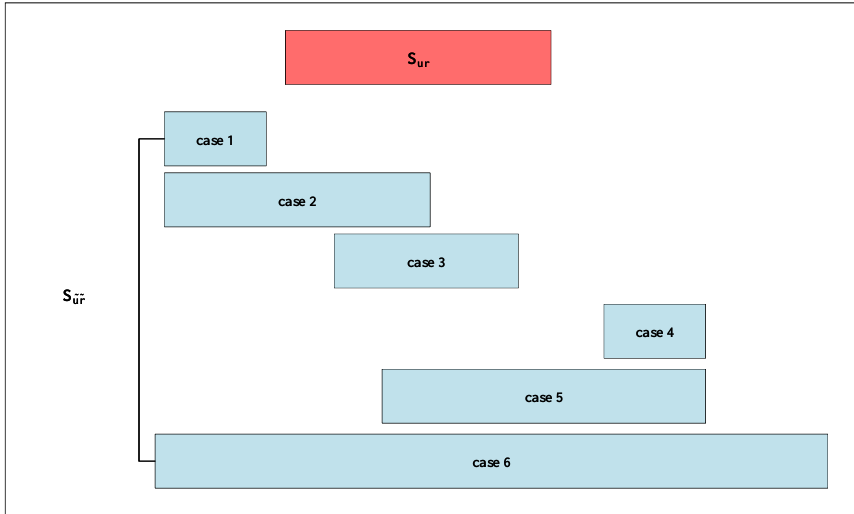
Figure 6. The relative position of the interval cut by the algorithm and the manual annotation interval. For cases 1–3, it can be seen that the ending point of the segmentations using the TS algorithm is smaller than those manually labeled. If the ending point of the blue parts is smaller than the starting point of the red part, there is no overlapping area. Therefore, max ( 0, ( ˜ r j − u i )) / | ˜ r j − u i | is used to eliminate case 1. Additionally, Figure 6 shows that the overlapping area can be obtained as follows: min ( ˜ r j , r i ) − max ( u i , ˜ u j ) + 1. For cases 4–6, similarly, the ending points of the blue parts are greater than the red part. Then, the total overlap point number of C and ˜ C is obtained as max ( 0, ( ˜ r j − u i )) / | ˜ r j − u i | × ( min ( ˜ r j , r i ) − max ( u i , ˜ u j ) + 1 ) . In summary, the overall calculation can be estimated in Equation